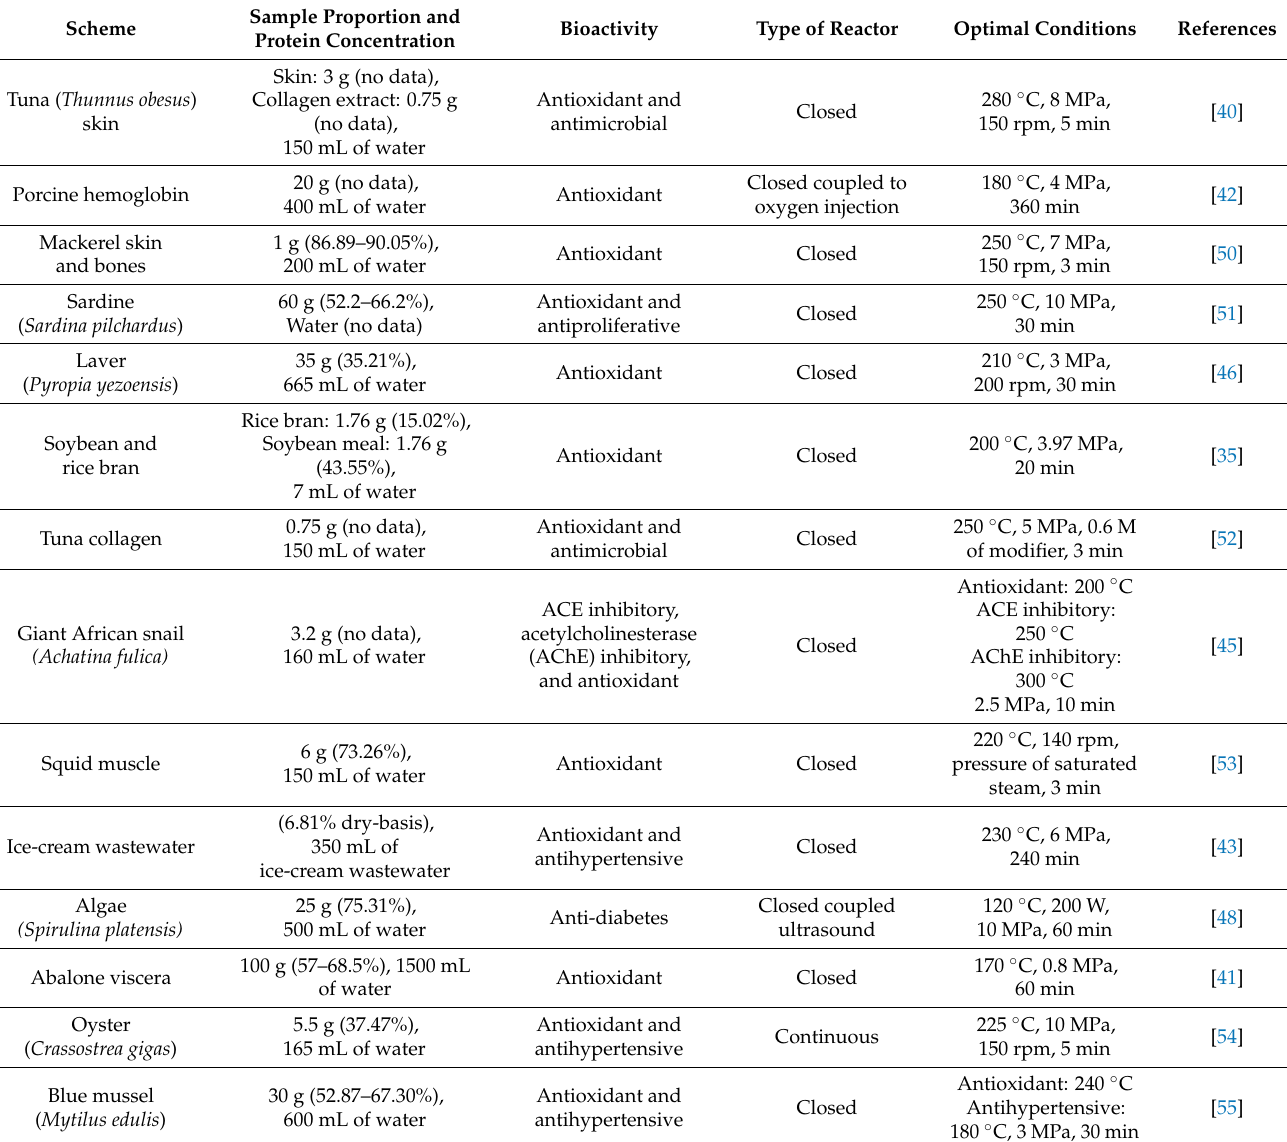
Table 1. Bioactivities and operation parameters found in the bibliography of different protein